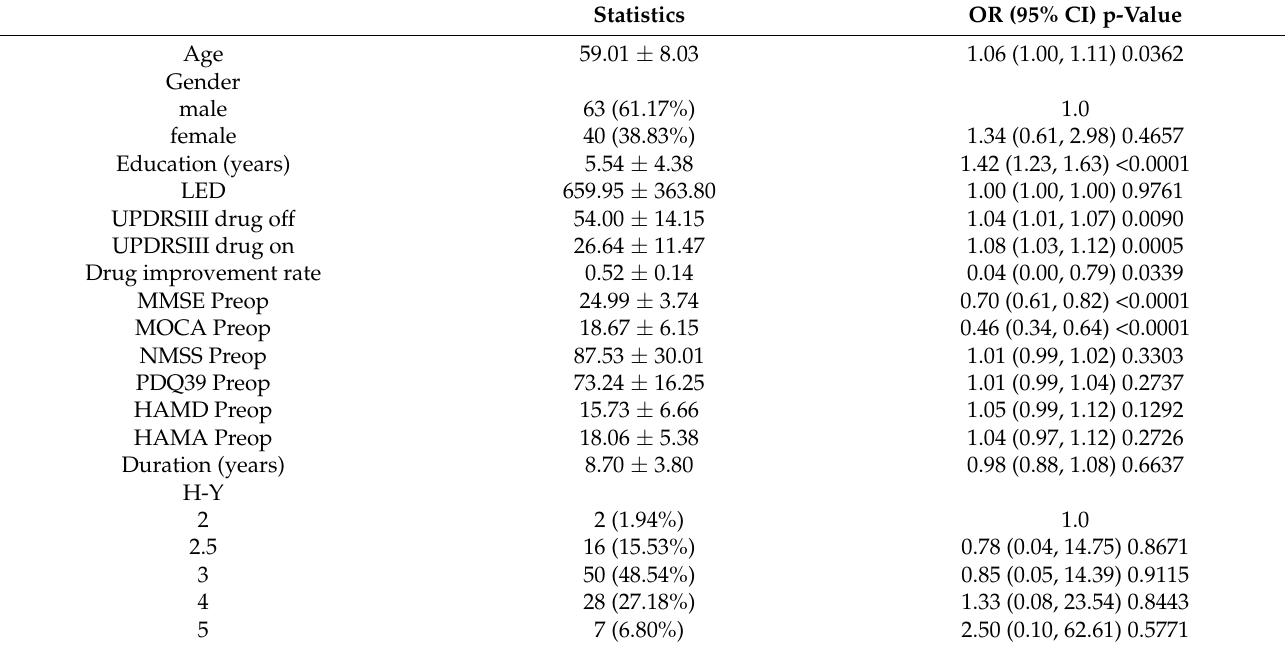
Table 2. Effect of characteristics of patients on improvement rate of cognitive state.